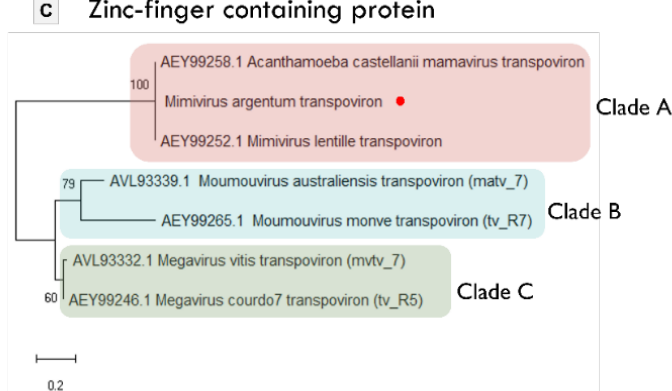
Figure 6. Phylogeny of three transpovirons core proteins. ( A – C ) Maximum-likelihood trees based on amino acid sequences from a hypothetical protein (ORF1), helicase domain-containing protein (ORF5), and zinc-finger containing protein (ORF6), respectively. The best-fit models chosen with ModelFinder (implemented in IQtree) for trees A, B, and C was JTTDCMut + F + G4, JTT + F + I, and VT, respectively. Mimivirus argentum transpoviron sequences are indicated by the red circle. Tree scale bars represent the number of amino acid substitutions per site.